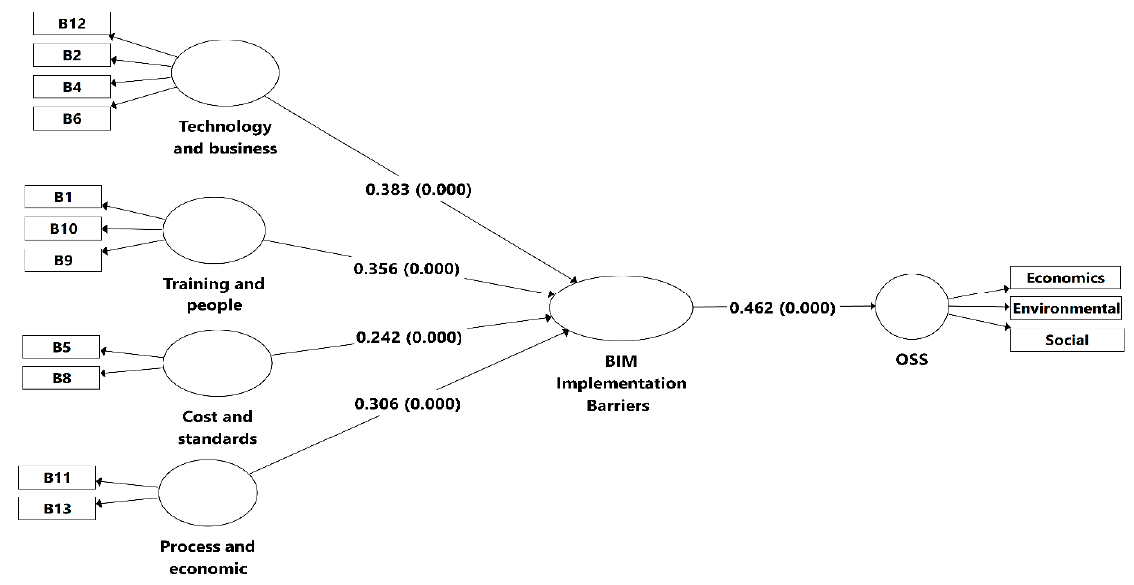
Figure 4. Bootstrapping analysis